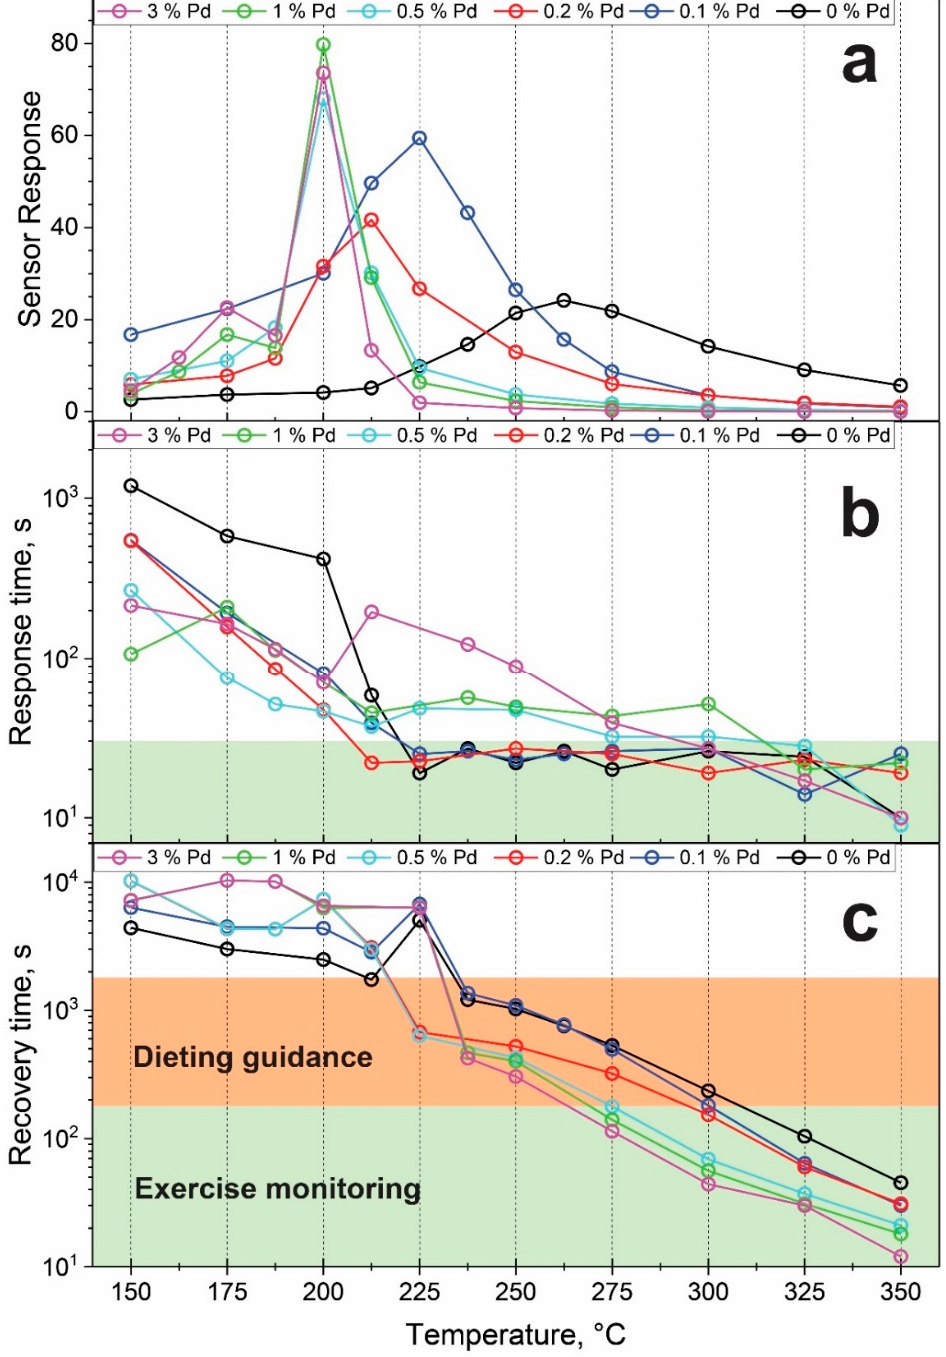
Figure 3. ( a ) Sensor response to 1 ppm of acetone (50% RH). Increasing the Pd loading shifts the sensing maximum to lower temperatures. ( b ) Response and ( c ) recovery times of these sensors.